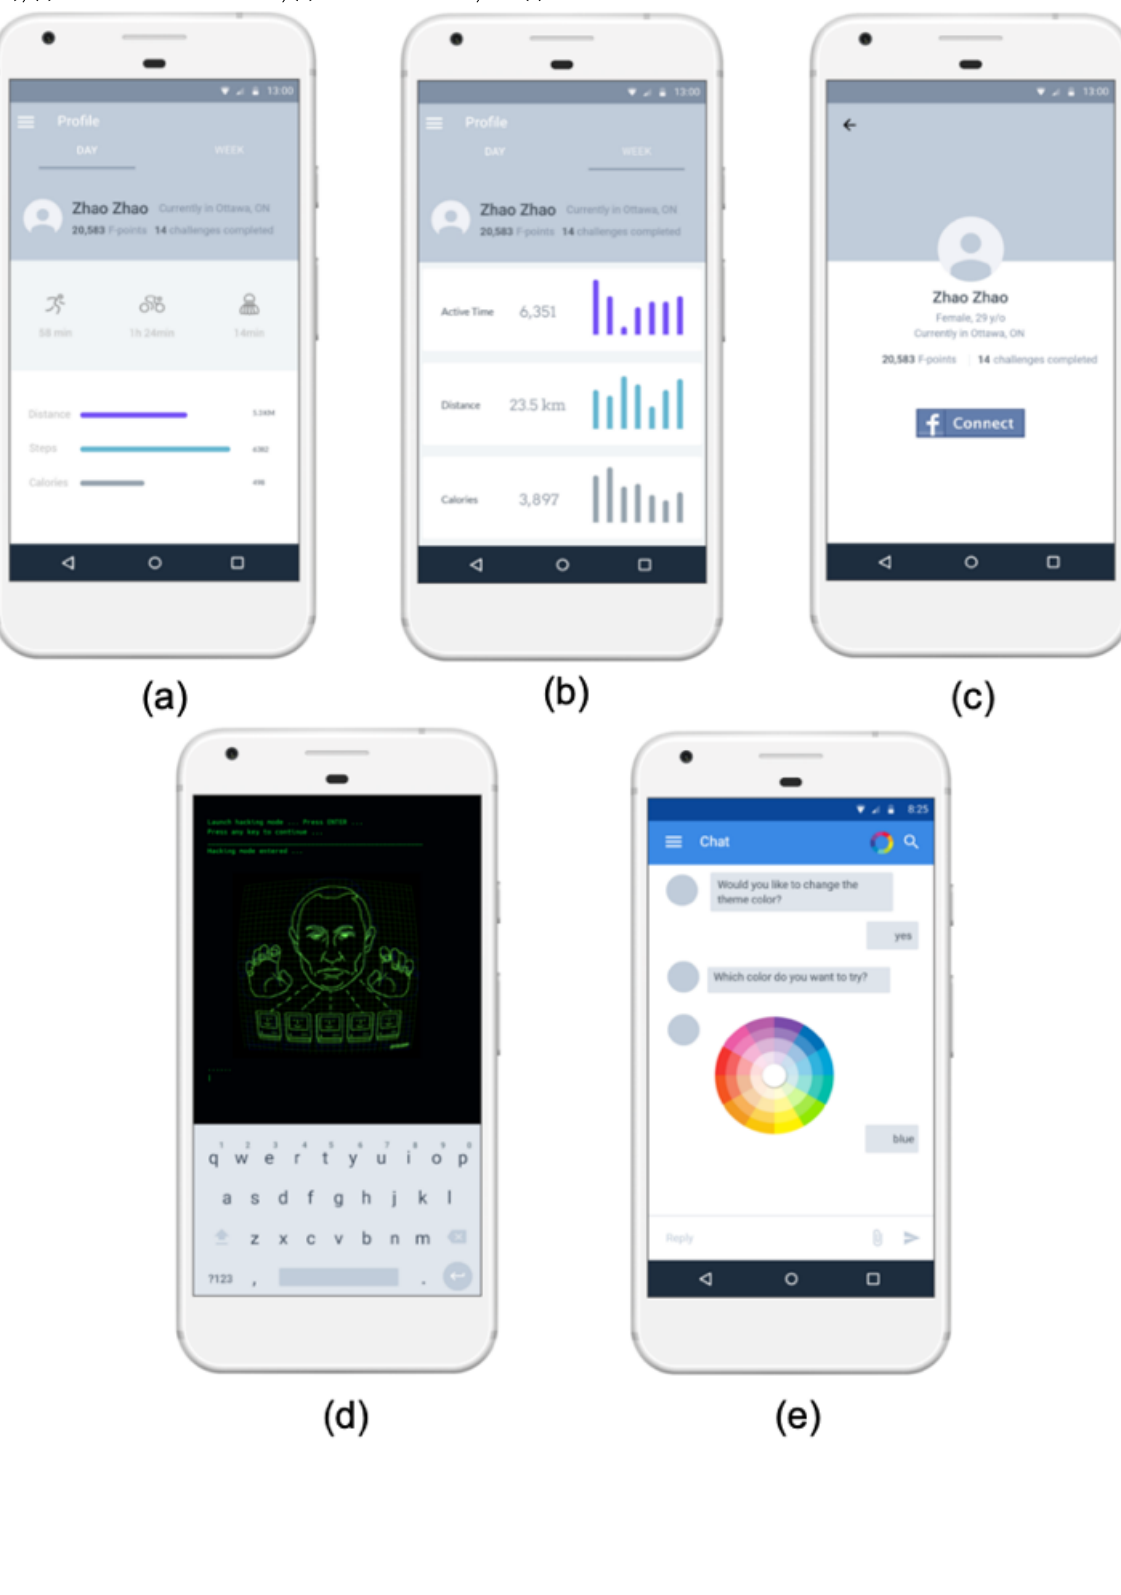
Figure 5. Example game elements: (a) profile in daily view (including points and challenges), (b) profile in weekly view (including points and challenges), (c) connect to Facebook view, (d) hacker mode view, and (e) theme color customization